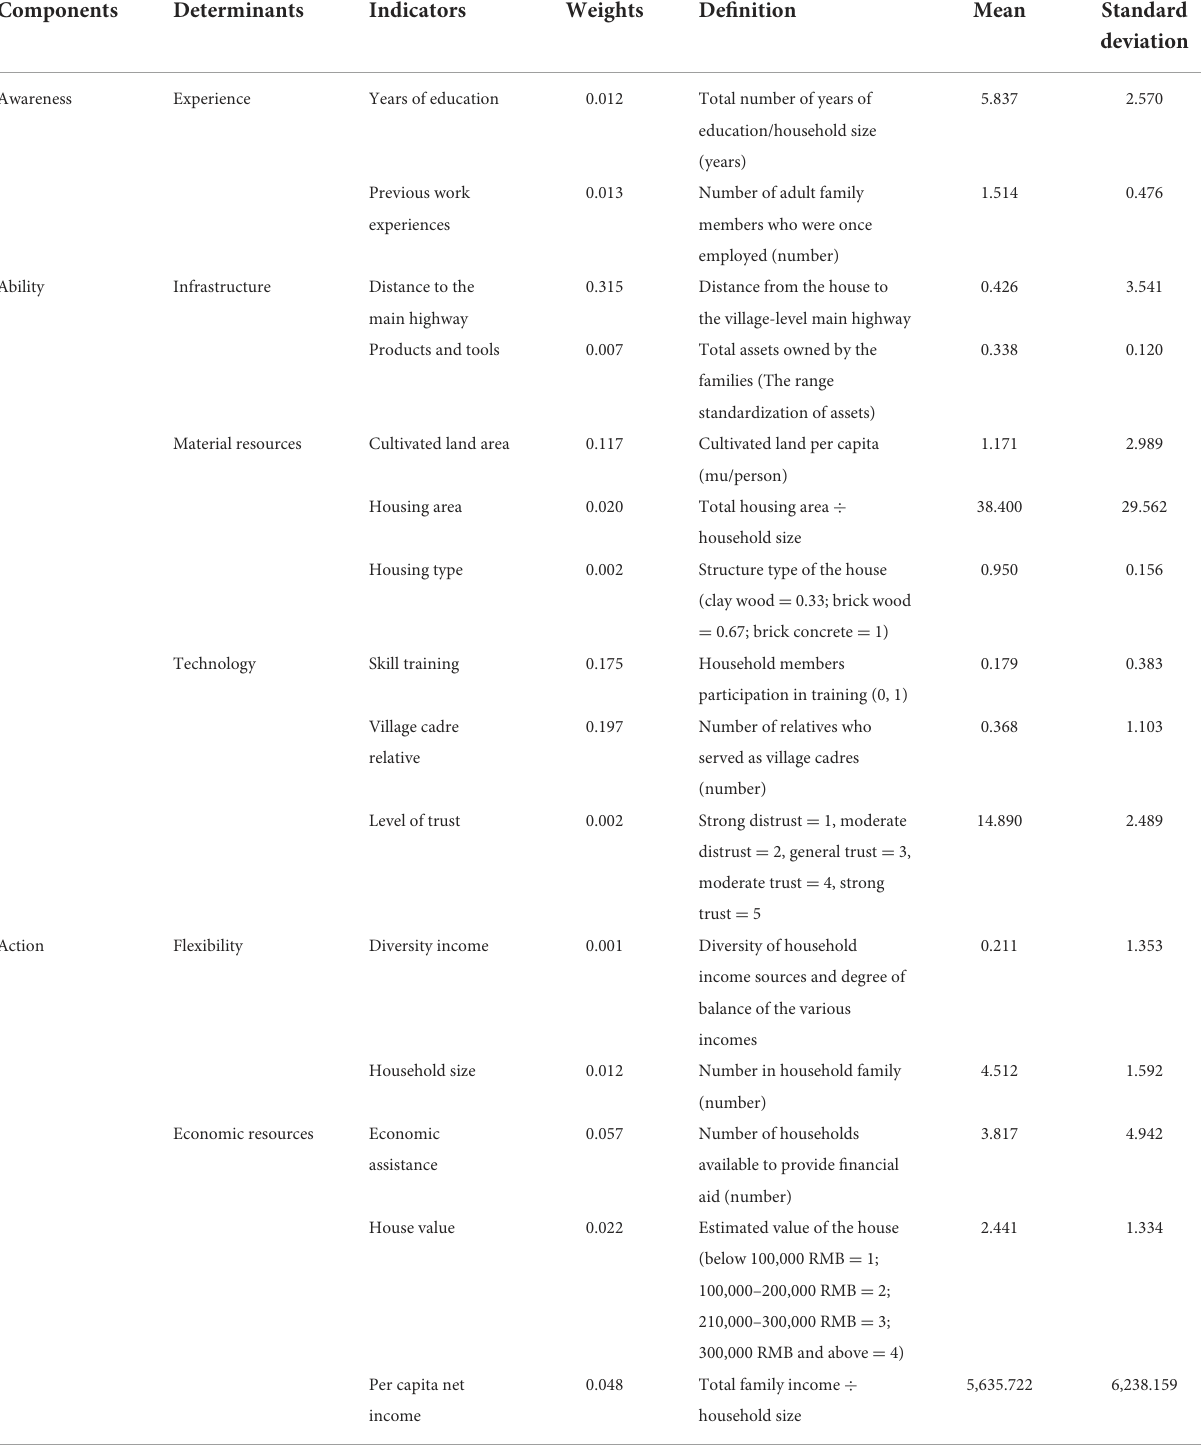
TABLE 1 Indexes of relocated households’ livelihood adaptive